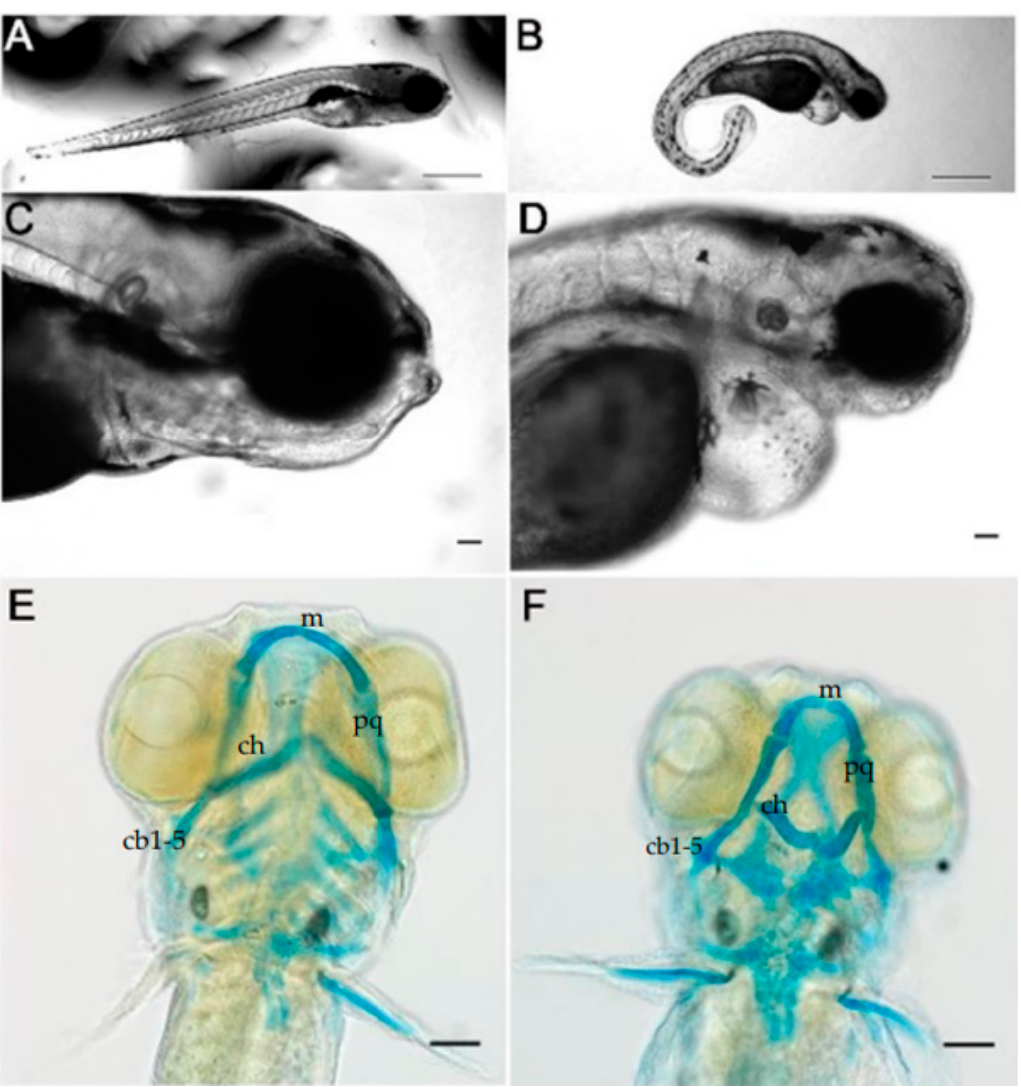
Figure 1. Col11a1a knockdown caused a curved body plan and reduced jaw size in zebrafish. Injection of a col11a1a targeting AMO induced a curvature of the body axis, while embryos injected with control AMO developed a straight body axis, ( A , B ); (( A , B ) reprinted under the terms and conditions of the Creative Commons Attribution (CC BY) license (https://www.mdpi.com/2221-3759/8/3/16; Ac- cessed on 15 July 2022) [25]. Normal face and jaw protrusion were present in the control zebrafish ( C ). In contrast, the morphant zebrafish demonstrated a reduction in face and jaw protrusion. Heart edema was also observed, ( D ). Alcian blue staining of the pharyngeal arch cartilages showed normal patterning and distally projecting cartilages ( E ), while Alcian blue staining in the morphant showed perturbed pharyngeal cartilage patterning characterized by a decreased protrusion of the 1st arch and a posteriorly facing 2nd arch, ( F ). Scale bar in ( A , B ) 0.5 mm; Scale bars in ( C – F ) 50 µ m. (m;